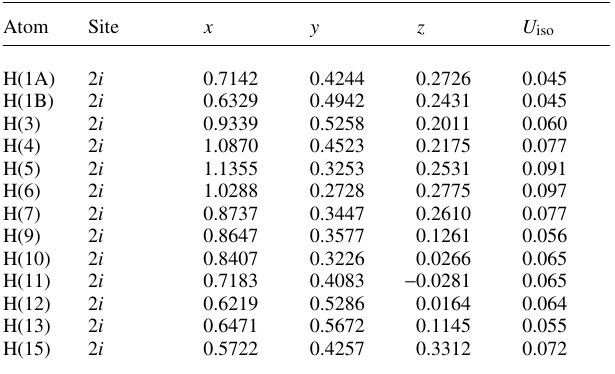
Table 2. Atomic coordinates and displacement parameters (in Å 2 ) . Atom Site